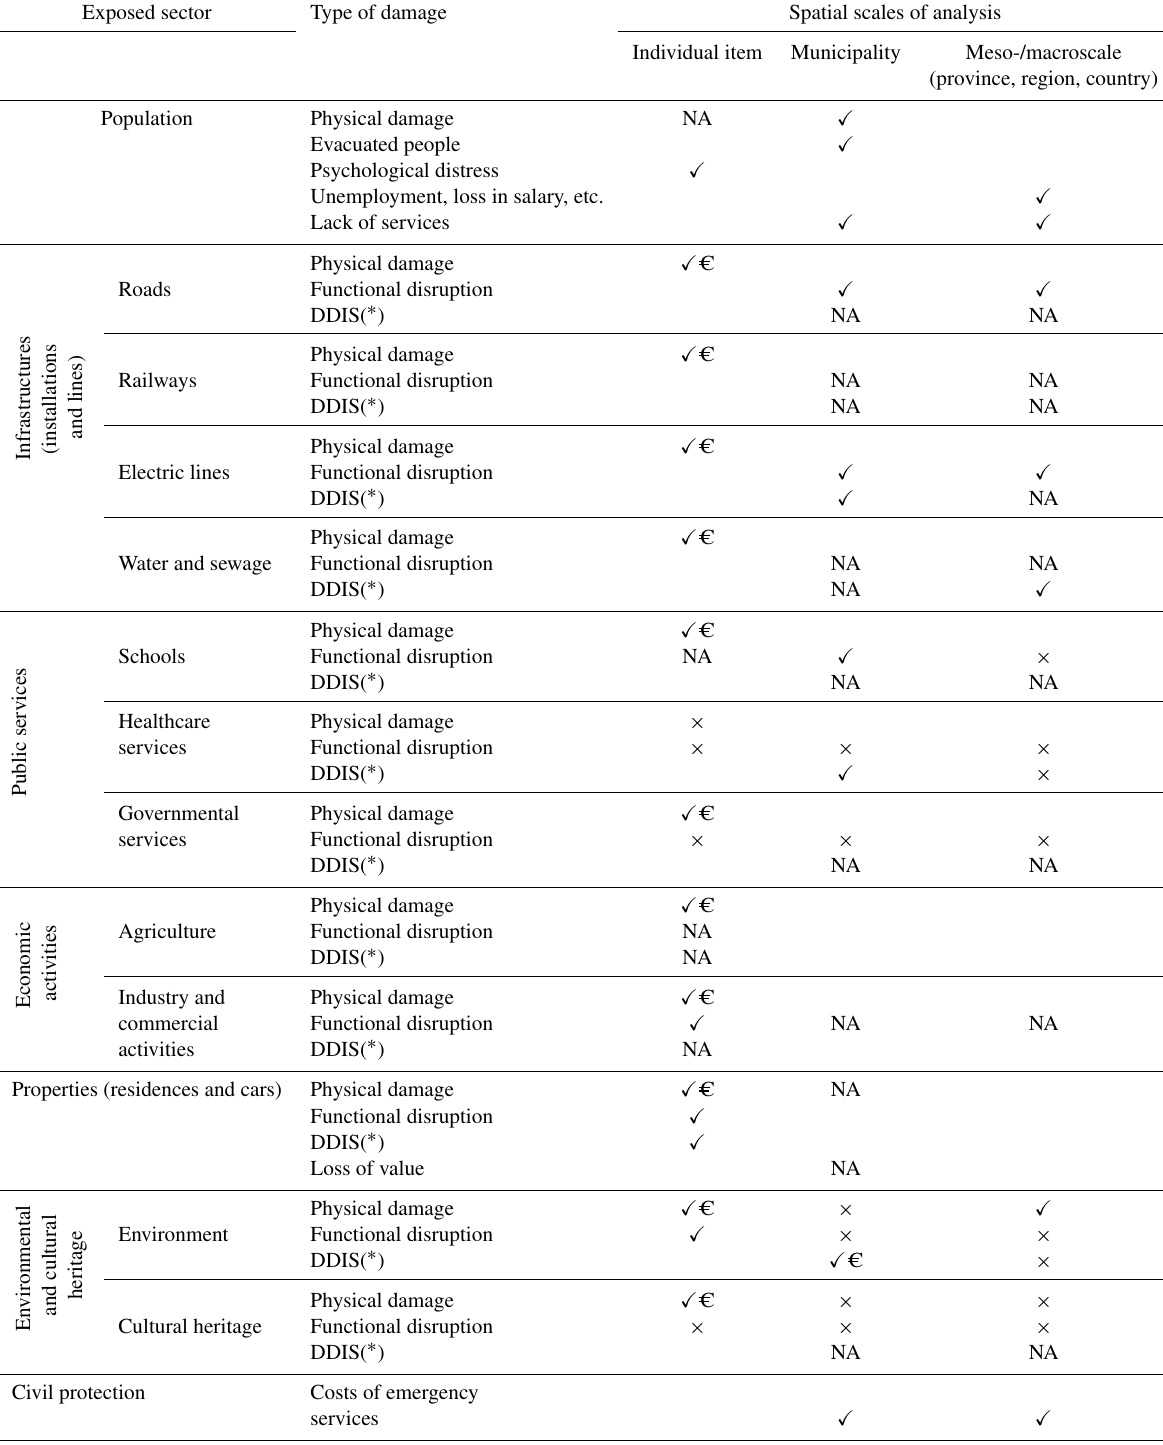
Table 2. Coverage of required flood information for the 2012 flood event in the Umbria